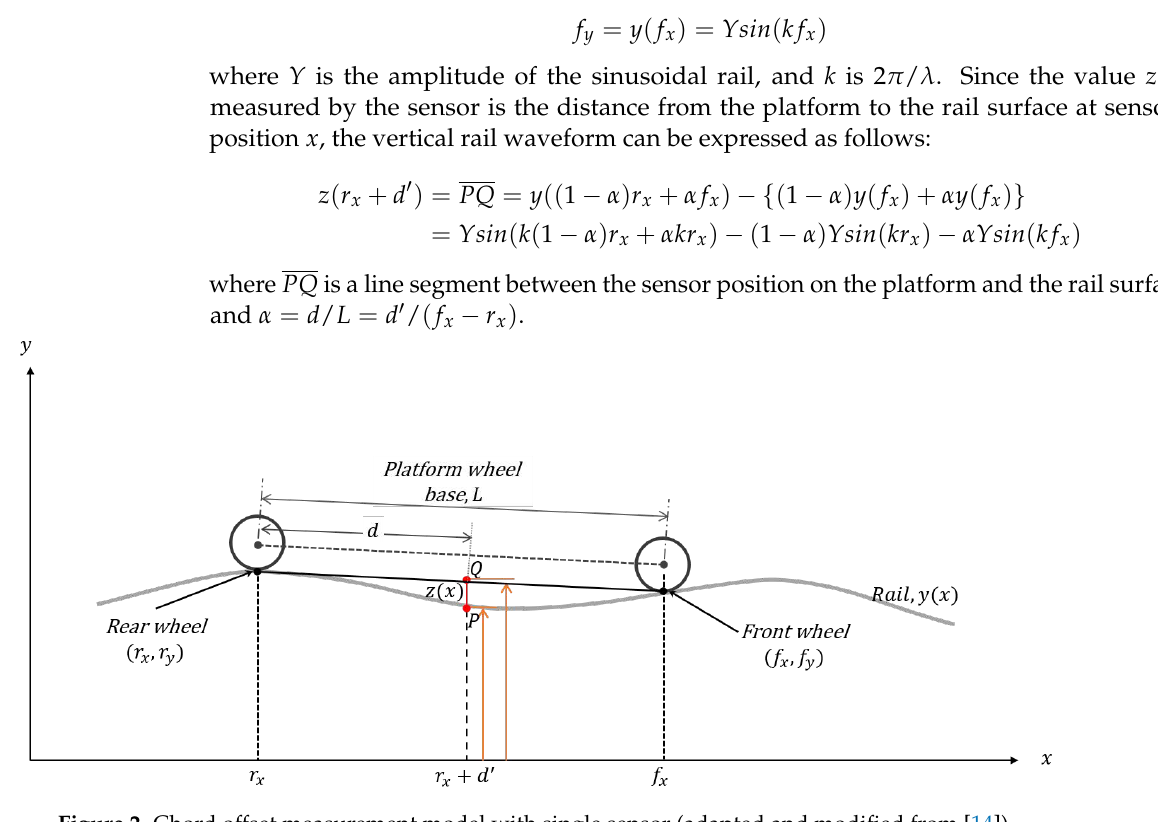
Figure 2. Chord offset measurement model with single sensor (adapted and modified from